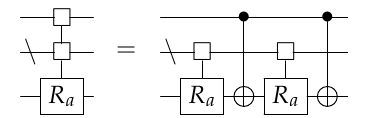
Figure 3. Partial decomposition of an F m